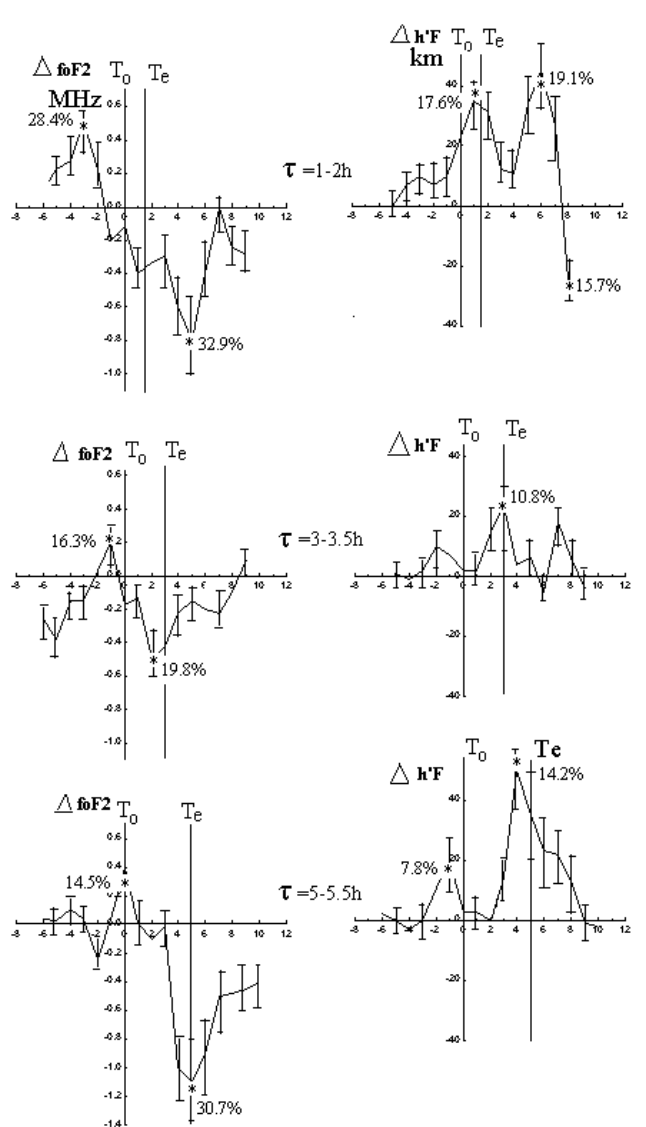
Fig. 3. The average variations of 1 fo F2 and 1h 0 F separated by duration into 3 classes: τ = 1 − 2h, τ = 3 − 3 . 5h, and τ = 5 − 5 . 5h. The vertical lines mark substorm onset, T o and the average end of the substorm, T e . Asterisks are δ fo F2 (%) and δh 0 F(%)